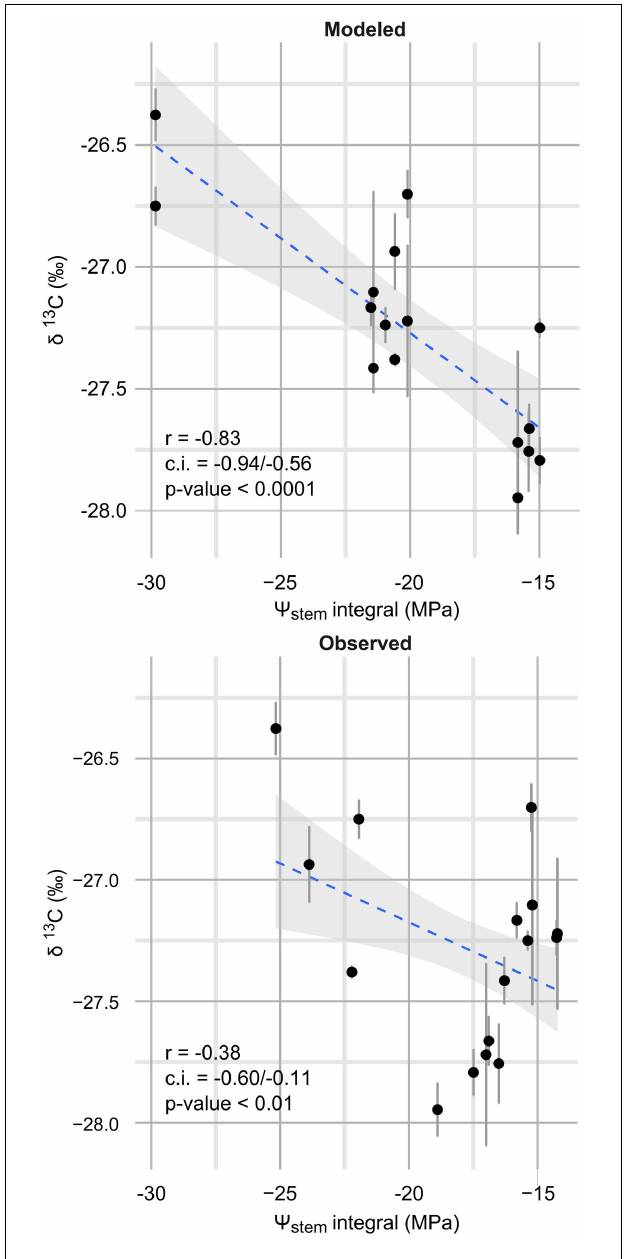
FIGURE 4 | Correlation between (cid:57) stem integrals and δ 13 C ( integrals were measured on all eight sites in 2012 and 2013 between veraison (2012-08-17; 2013-08-15) and harvest (2012-09-20; 2013-09-13). Upper panel: (cid:57) stem integrals measured on the daily (cid:57) stem trend as estimated by the model; lower panel: (cid:57) stem integrals measured on the measured trend (observed), at weekly time scale. Error bars are standard deviation of δ 13 C biological replicates. The blue line is the best fit (OLS regression); the shaded area shows the confidence intervals for this